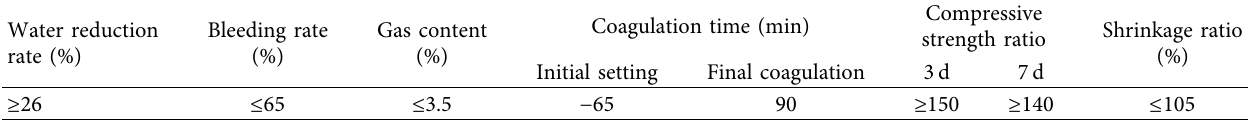
Table 1: Performance index of polycarboxylate superplasticizer.